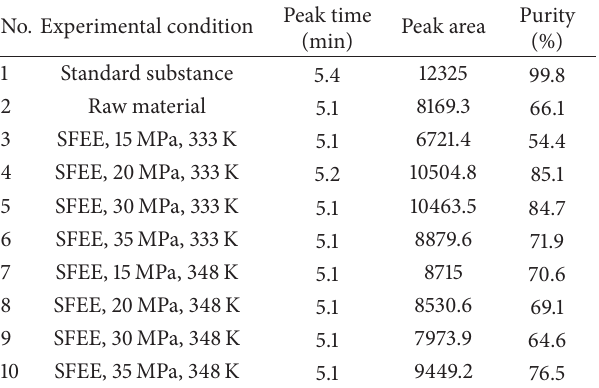
Figure 3: Stearic acid purity trend chart (serial number meaning with Table 1). Table 1: Test results of stearic acid by